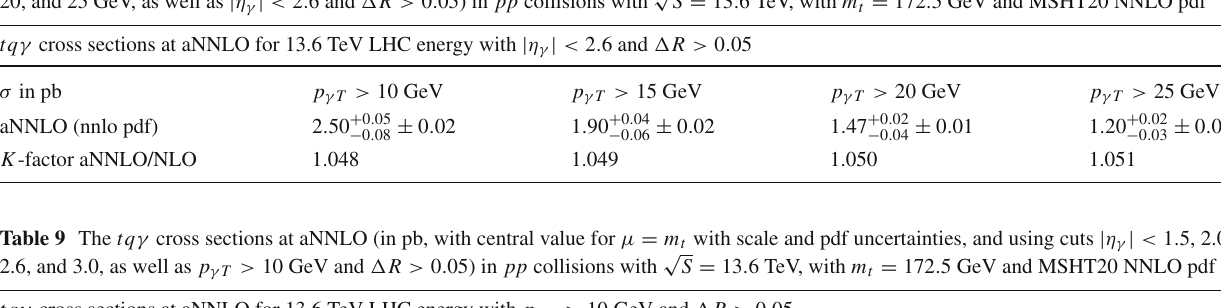
√ S = 13 . 6 TeV, with m t = 172 . 5 GeV and MSHT20 NNLO pdf